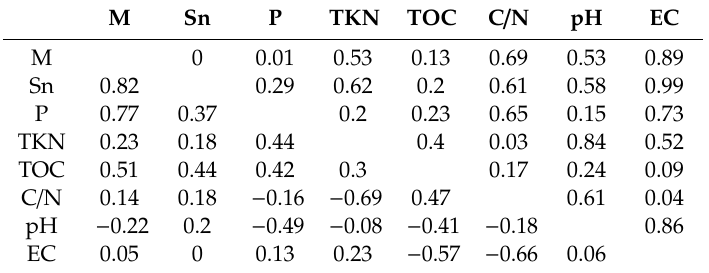
Table 4. Fo soil parameters’ correlation coe ffi cients (left down) and corresponding p -values (right up); significant cases are highlighted.